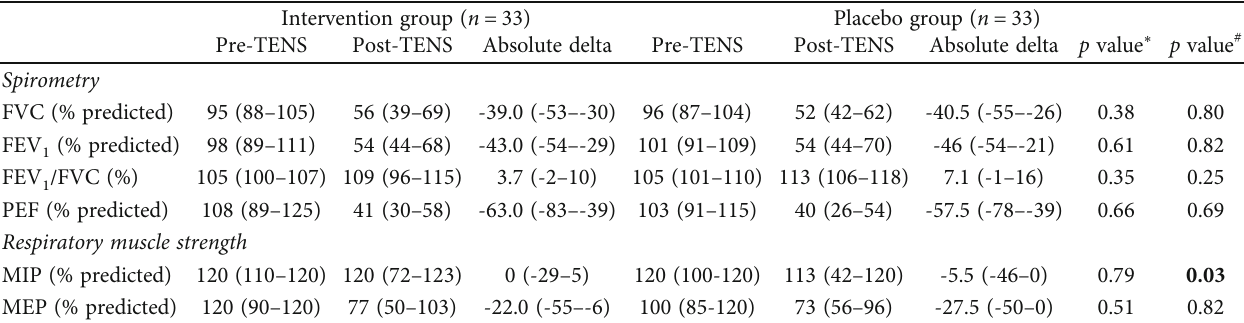
Table 2: Lung volume and capacity and muscle strength before and after the application of TENS and